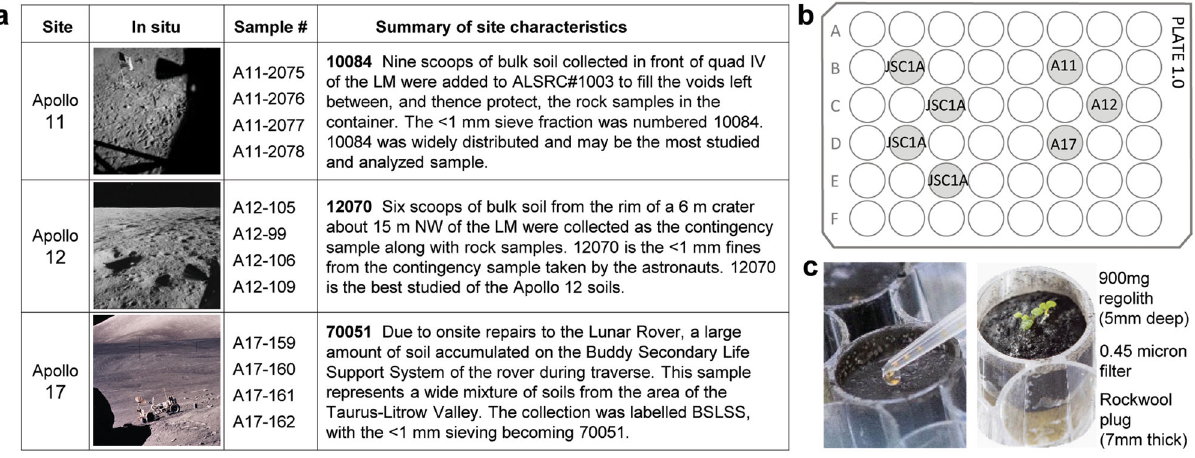
Fig. 1 Lunar regolith sources and experiment set up. a A summary table of lunar sample sources 50 . b We used four replicate plates, each 48-well cell culture plate contained four wells of JSC-1A simulant and three of lunar regolith (one well each per plate) – Apollo 11 (A11), Apollo 12 (A12), Apollo 17 (A17). c Each well contained 900 mg of regolith material layered over a 0.45-micron fi lter and Rockwool wick and was sown with 3-5 Arabidopsis seeds suspended in water (also Supplementary Fig. 1). Lunar In Situ images are publicly available from NASA